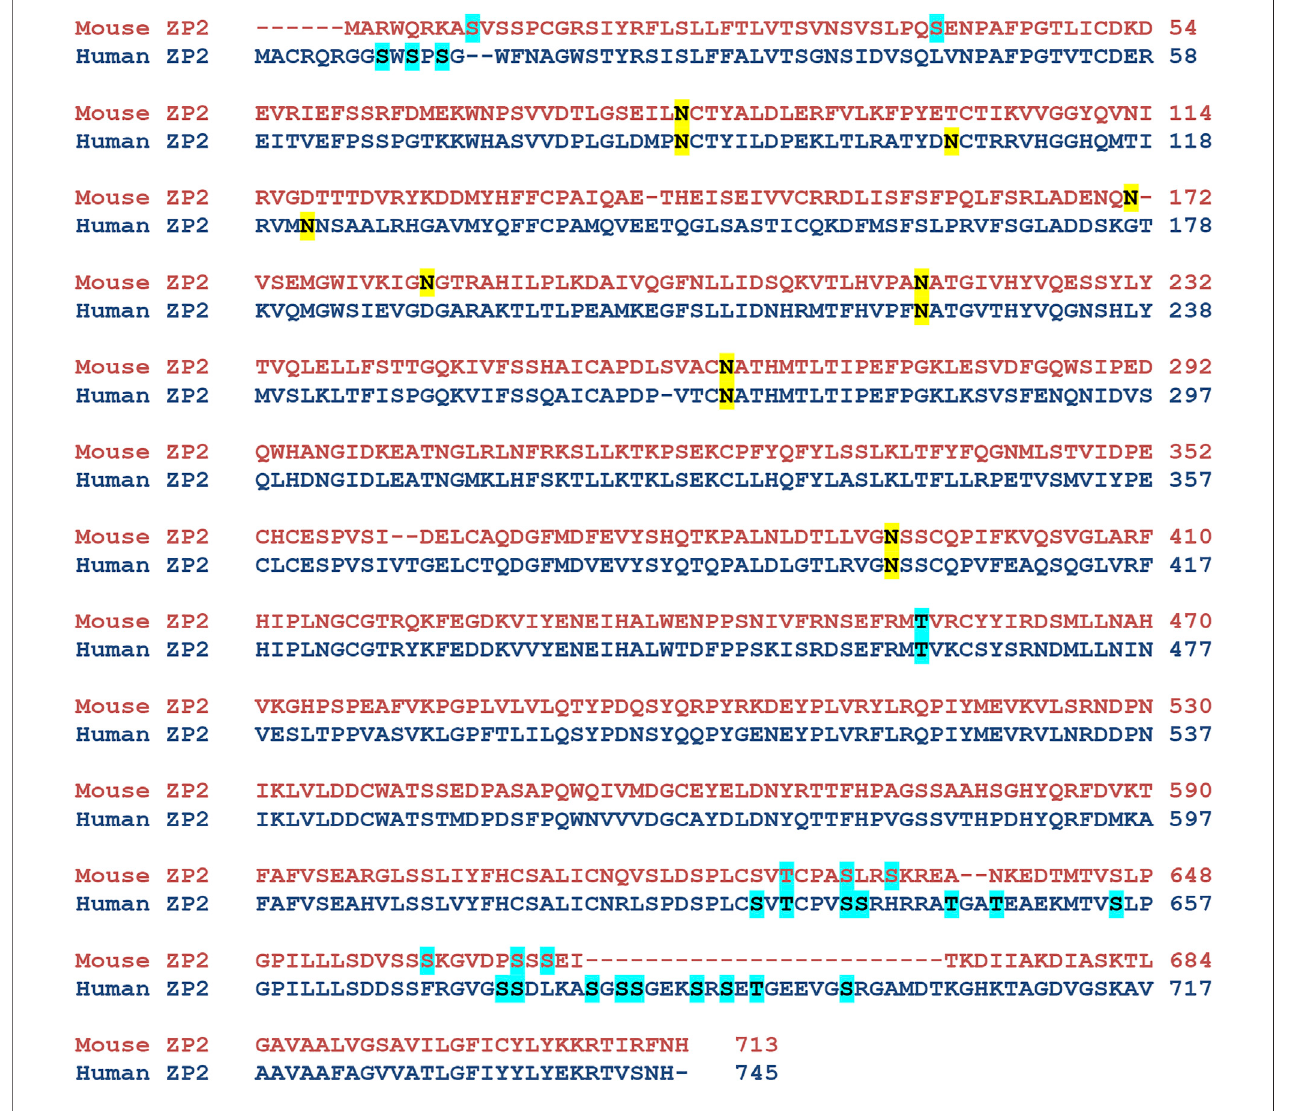
FIGURE 4 | Prediction of N- and O-linked glycosylation sites in hZP2 protein. NetNGlyc-1.0 and NetOGlyc-4.0 were used to predict N-linked and O-linked glycosylationsitesinhZP2respectively.AnadditionalO-glycosylationsiteatT 462 ,basedonthedatafromnativemouseZP2massspectrophotometricstudies,wasalso assigned manually. The N-linked and O-linked glycosylation sites in mouse and human ZP2 are highlighted in yellow and cyan respectively.